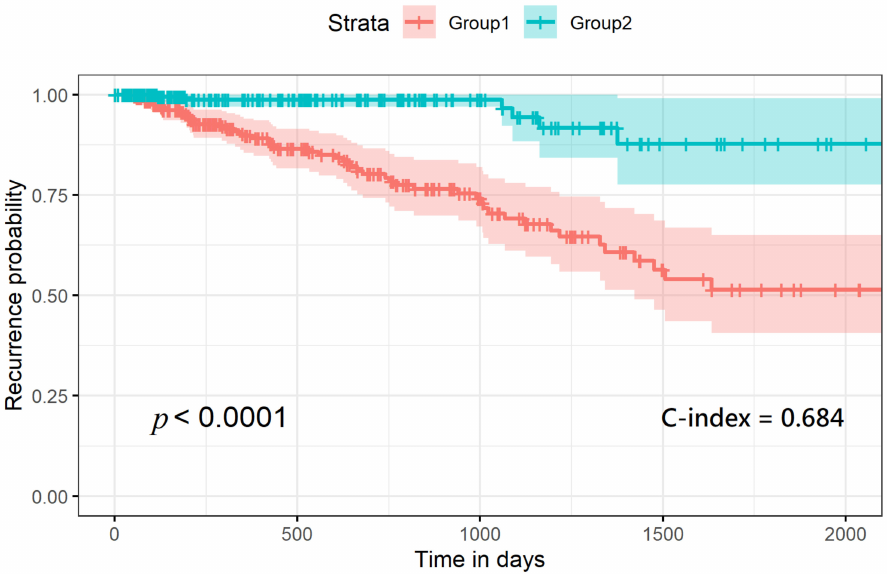
Figure 5. Recurrence-risk curves according to the labels derived from the autoencoder model.